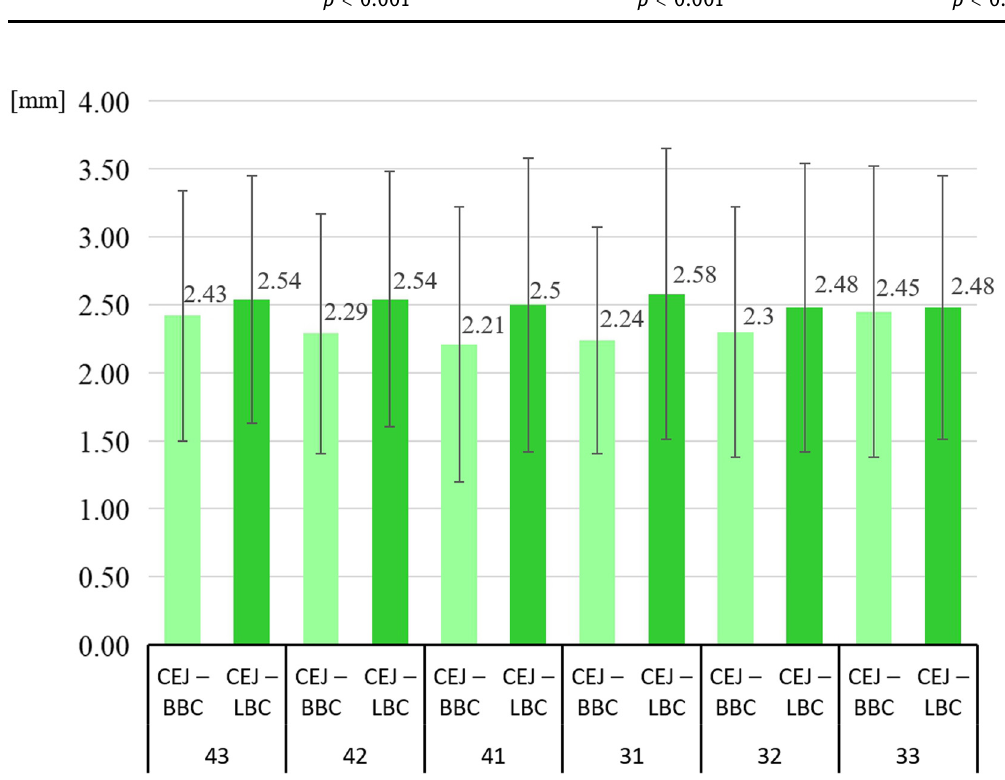
Con fi dence interval ( 95.0% )